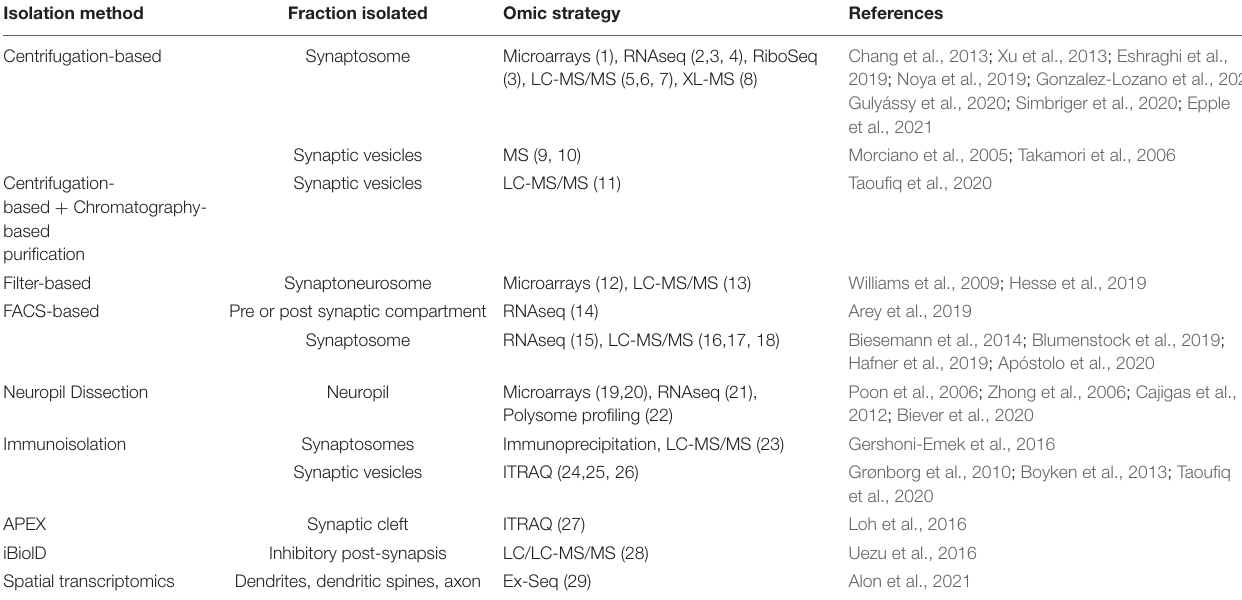
TABLE 2 | Summary of synaptic isolation strategies implemented for omics